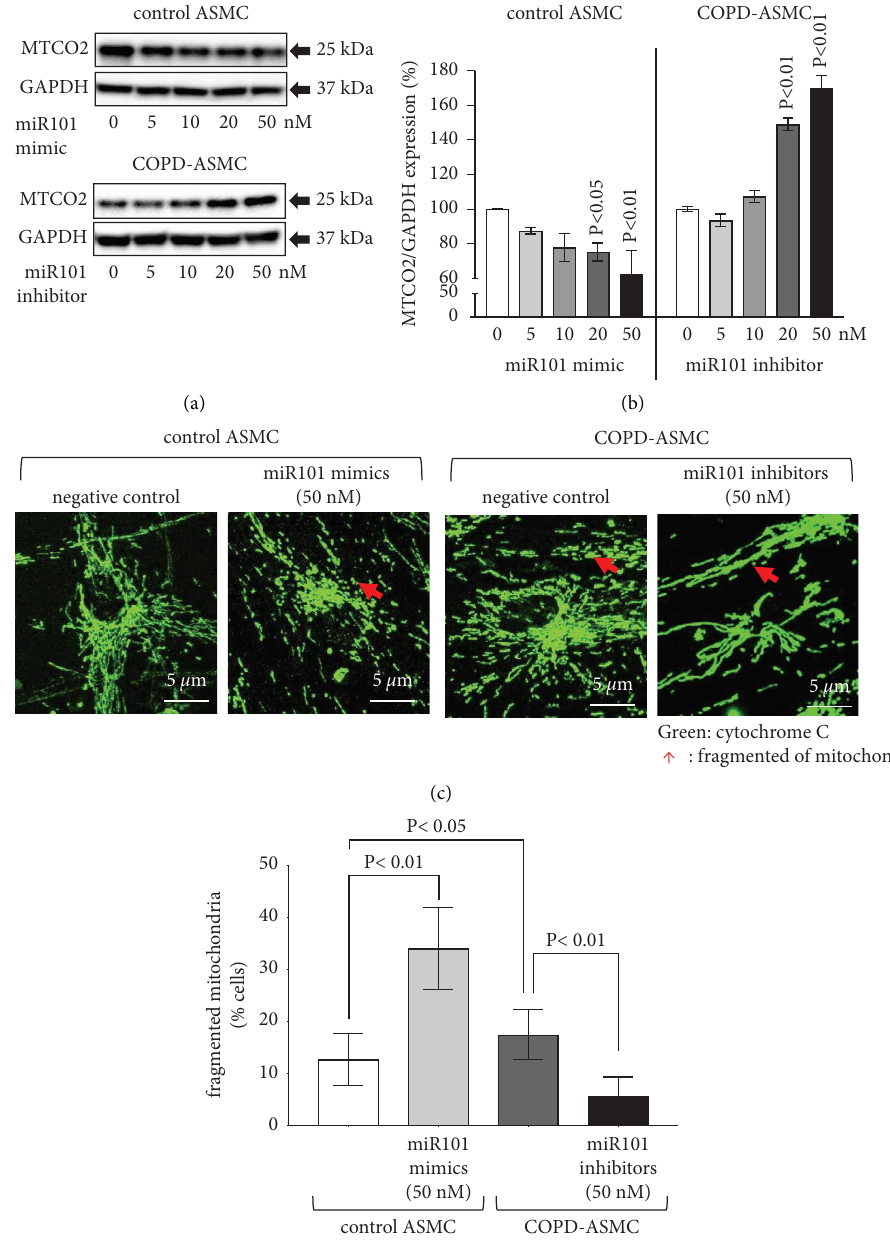
Figure 2: Disease-specifc efect of miR-101-3p on ASMC mitochondria. (a) Western blots of mitochondria cytochrome c oxidase subunit II (MTCO2) protein expression in commercial ASMC (healthy nonsmokers (control): n � 3; COPD: n � 3) treated with miR-101-3p mimics (controls) or inhibitors (COPD). (b) Bars represent the mean ± S.E.M. of MTCO2 expression (image analysis) of three Western blots, as shown in Figure 2(a). P values present comparison to untreated cells. (c) Z-stack projection photos acquired by confocal microscopy (Nikon, 60x magnifcation) of fragmented mitochondria morphology in ASMC of healthy nonsmokers (control, n � 3) treated with miR-101-3p mimics, or COPD-ASMC ( n � 3) treated with miR-101-3p inhibitors, over 24 hours. Mitochondria are visualized by cytochrome c (green) staining. (d) Image analysis of fragmented mitochondria as described in Figure 2(c). Bars represent mean ± S.E.M. of disease-specifc efects of miR-101-3p mimics and inhibitors on MTCO2 expression (300